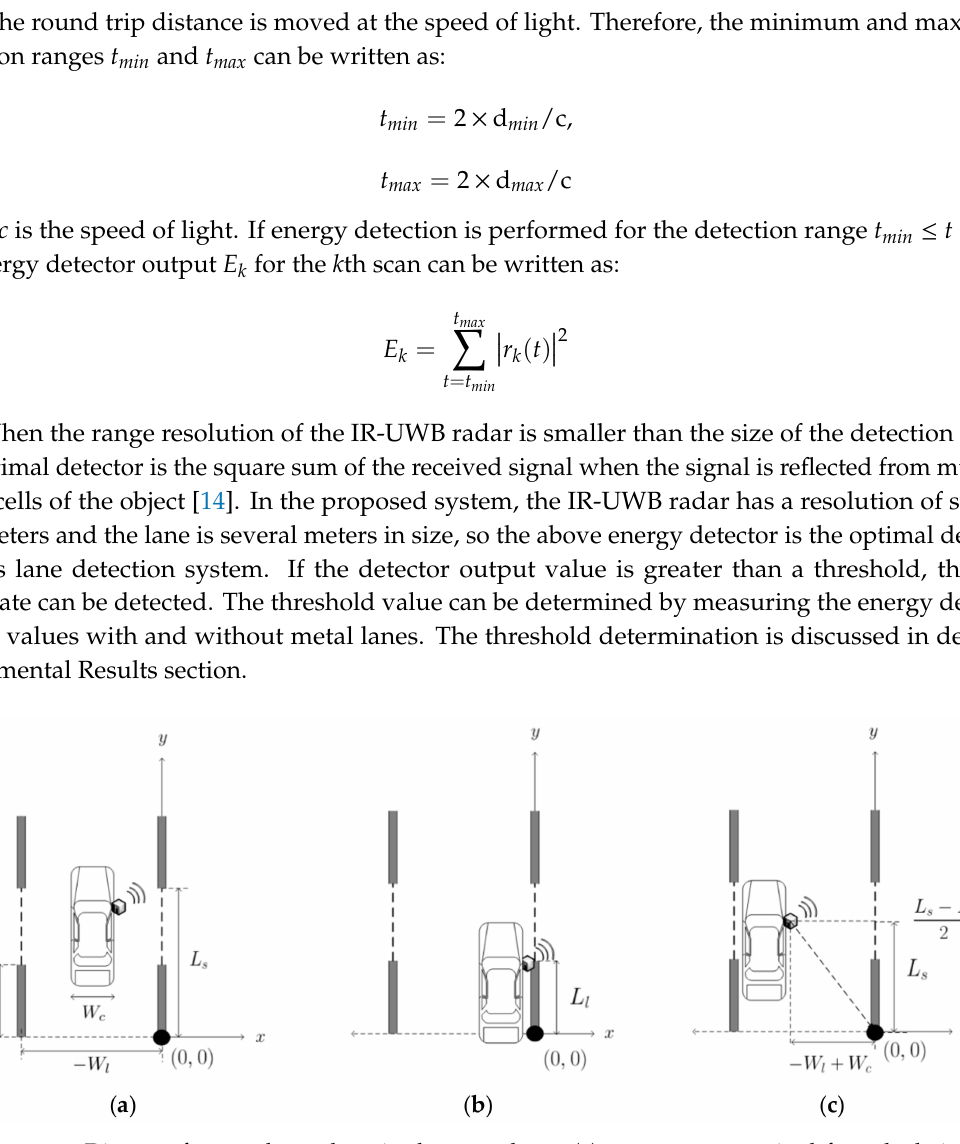
Figure 3. Distance from radar to lane in the x , y plane: ( a ) parameters required for calculation; ( b ) example at minimum; and ( c ) example at